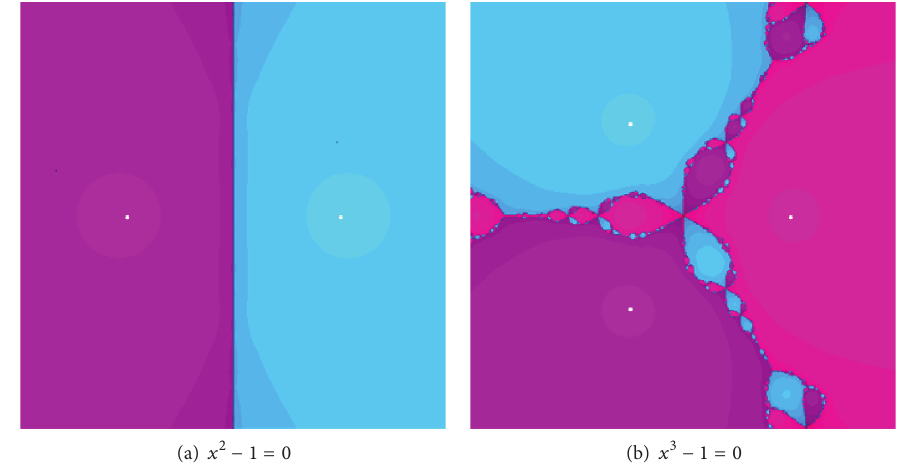
Figure 5: Basins of attraction (16) shaded according to the number of iterations.